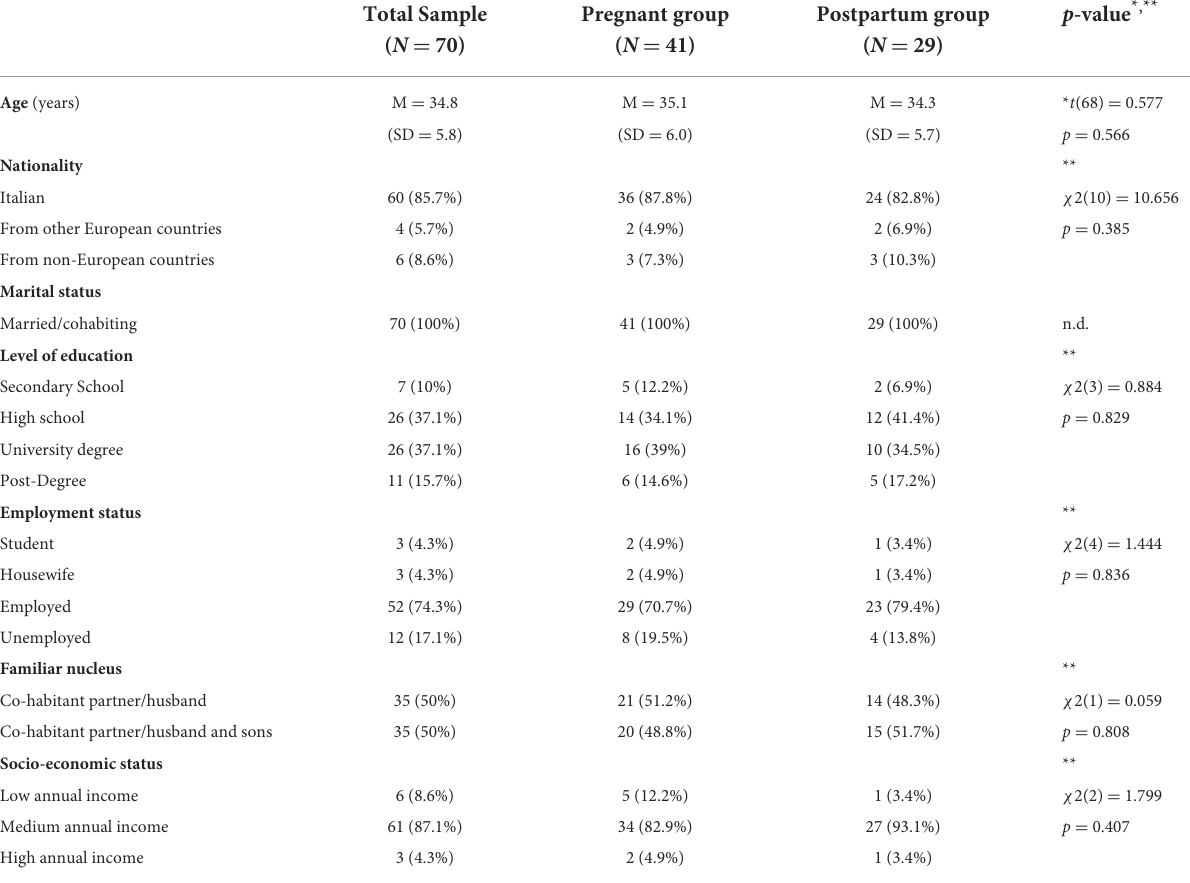
TABLE 1 Socio-demographic characteristics of the sample.